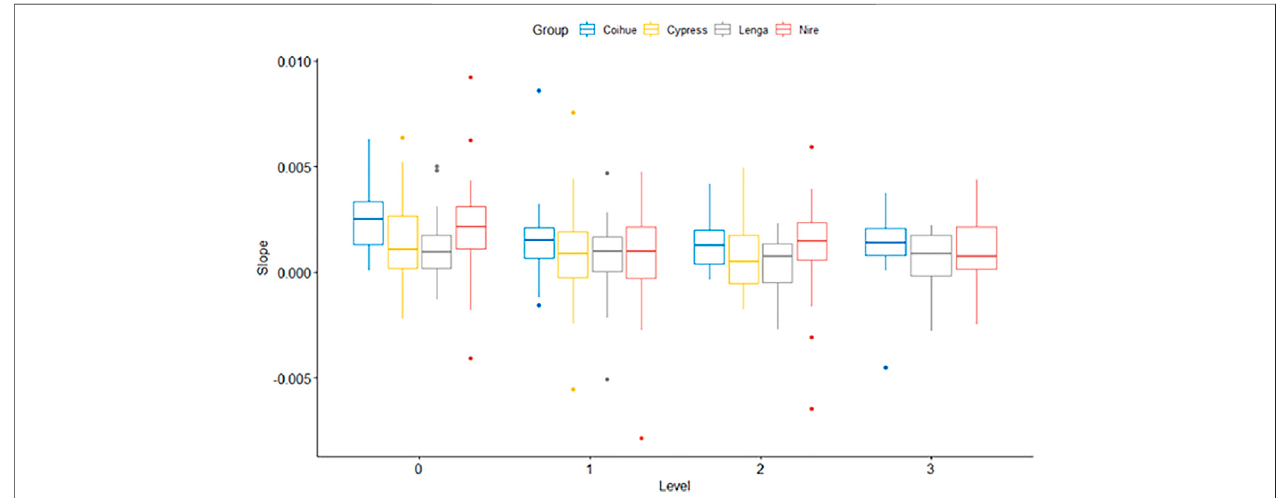
FIGURE6| ComparisonamongtheNDVIincreasesovertime,indicatedaspositiveslopevalues,foreachofthefourmostcommondominanttreespecies,among the different levels of protection. 0: unprotected area, 1: National Reserve, 2: National Park, and 3: Strict Nature Reserve.